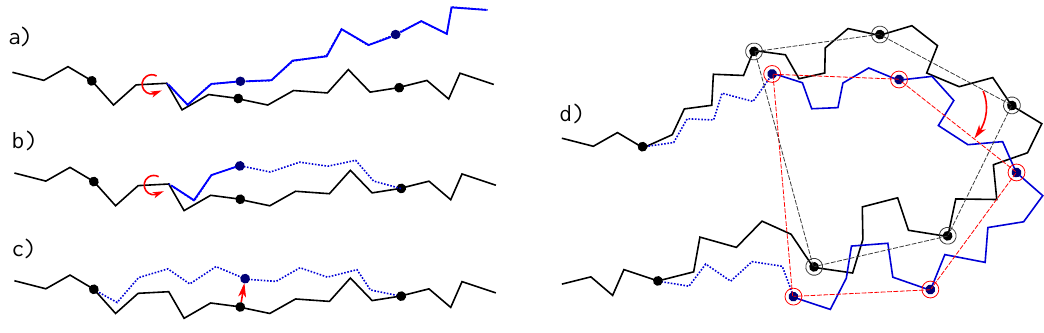
Figure 1. Illustration of the implemented move classes. ( a ) pivot move, which is the most frequently used move class within MC methods applied to chain-like molecules; ( b ) concerted rotation, as implemented using the proposed tripeptide-based model; ( c ) local move produced by the perturbation of the particle associated with one tripeptide; and ( d ) hinge move produced by a correlated perturbation of a set of particles. The protein backbone trace before and after the move are drawn in black and blue, respectively. Tripeptides that change their conformation are represented with dashed lines.